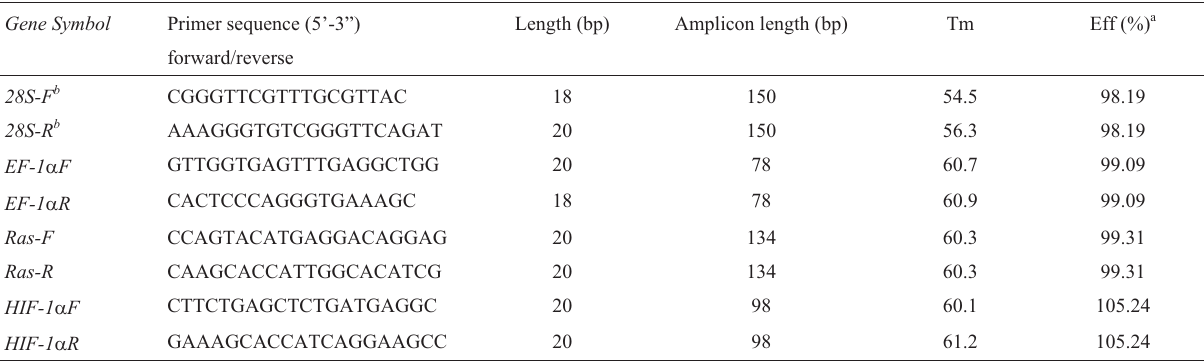
Table 1 - Details of primers designed for reference genes ( 28S and ef-1 (cid:2) ) and the two target genes ( ras and hif-1 (cid:2) ). Gene